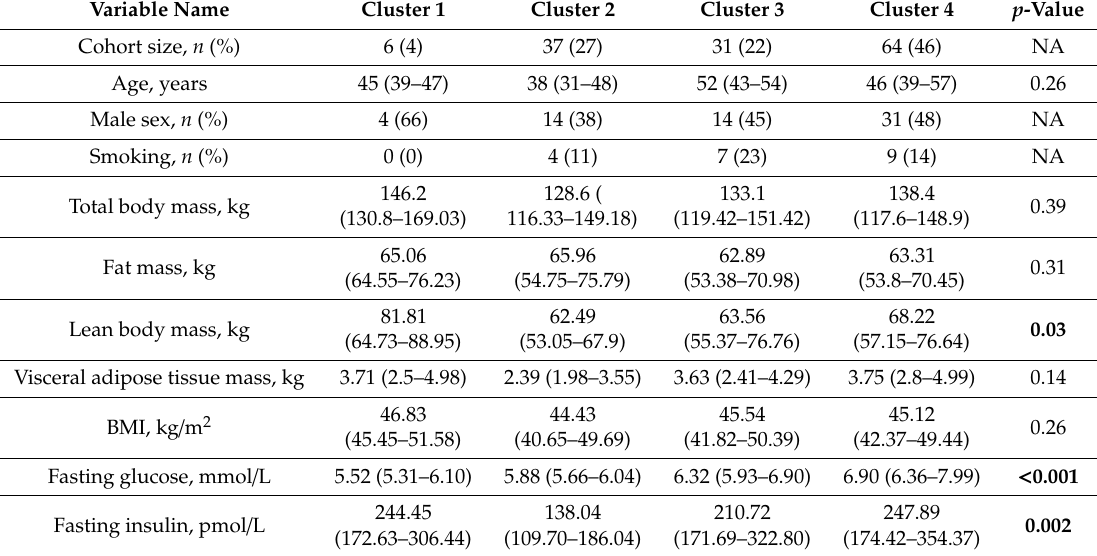
Table 2. Medians (interquartile range) at baseline divided by OGTT cluster. p-val is for p-value from non-parametric median tests testing whether medians significantly di ff ered. NA, not applicable; HOMA, homeostasis model assessment; AUC, area under the curve; MET, metabolic equivalent of task; Bold indicates significant p-values ( p <